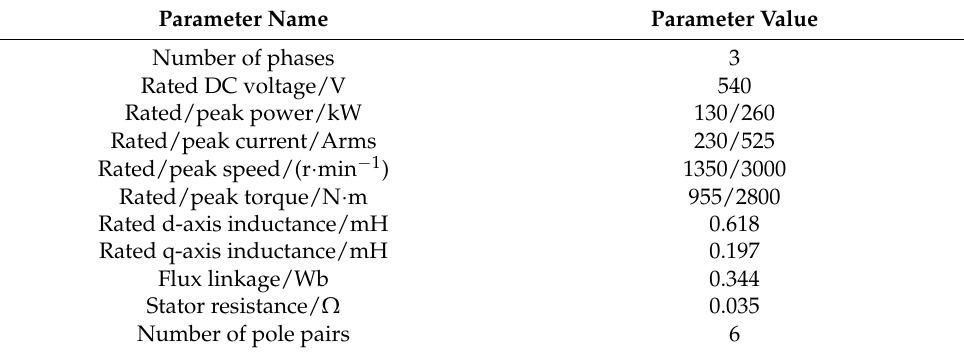
Figure 3. PMSM single closed loop control block diagram. Table 1. Motor parameters.